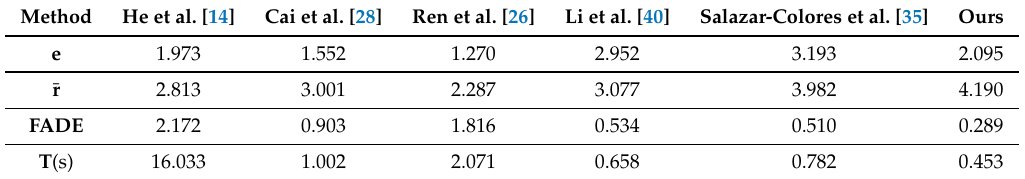
Table 4. The average values of e , ¯ r , FADE , and T on real-world hazy images of the comparative methods.